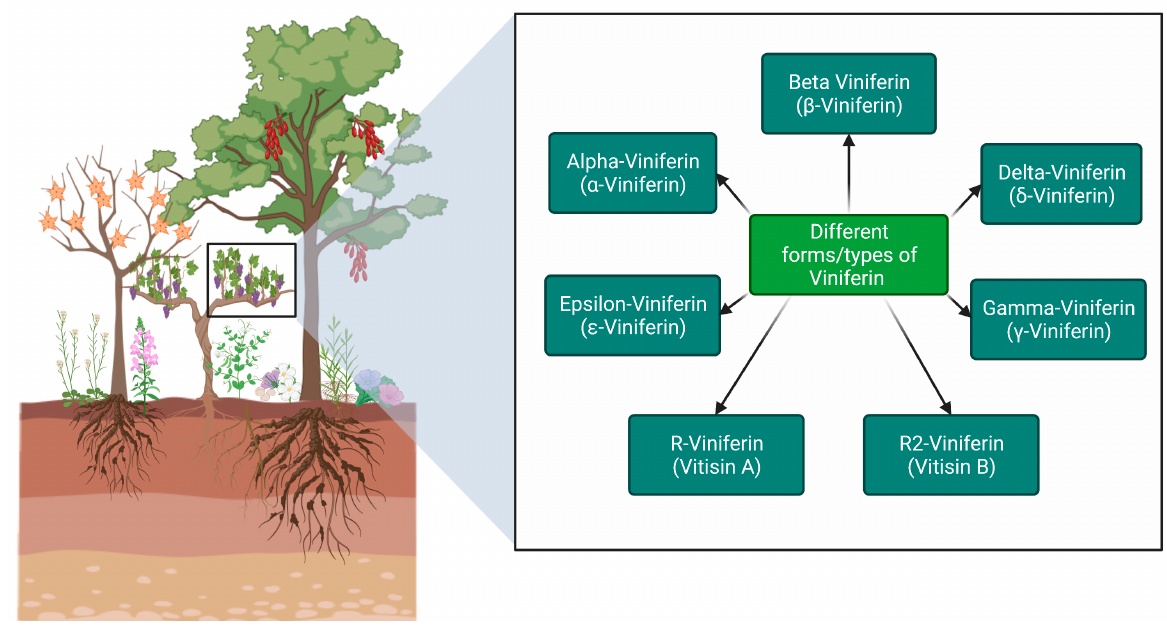
Figure 1. Different types of viniferin.